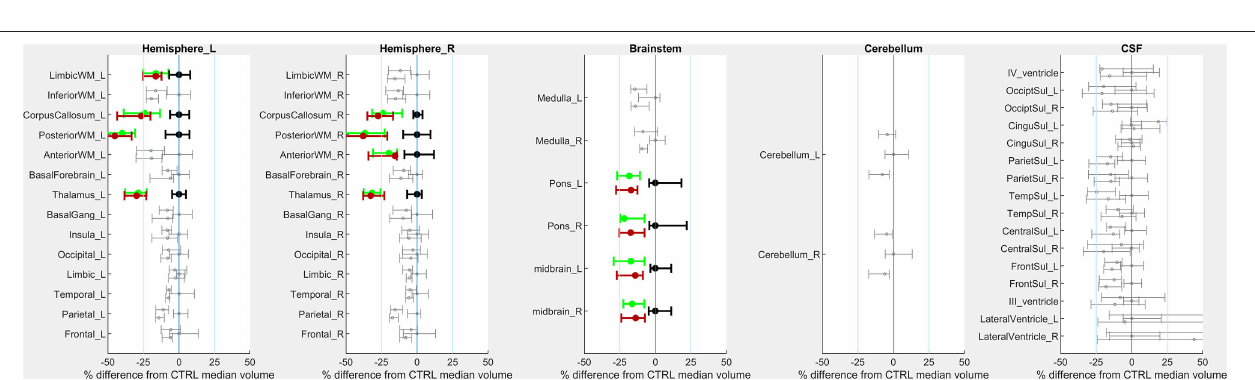
FIGURE 1 | PRE- vs. POST-intervention group-level imaging characteristics–Volumetric analysis. For each region of interest (ROI), error bars indicate median and 95% confidence intervals of ROI volumes for children with CP PRE-intervention (highest of each triplet), POST-intervention (lowest of each triplet), and CTRL children (middle of each triplet). X-axis volumes are normalized in terms of % difference from median CTRL ROI volume. Bolded, colored triplets of error bars (CP-PRE = green; CTRL = black; CP-POST = red) indicate ROIs with significant CP-PRE vs. CTRL group differences surviving Bonferroni-Holm correction (53 ROIs compared in Level 3-resolution analysis). See Supplementary Figure for full Level 1–5 analyses. ROI designations reflect those of the MRIcloud MPRAGE atlas (19).